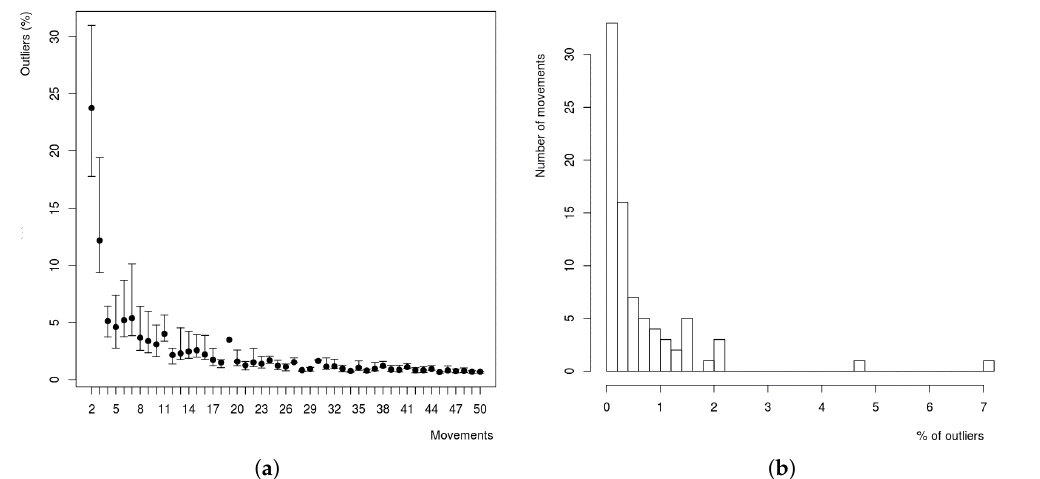
Figure 5. Movement validation: ( a ) Overall percentage of outliers when the model is built using a specific number of random movements, ( b ) percentage of outliers in each